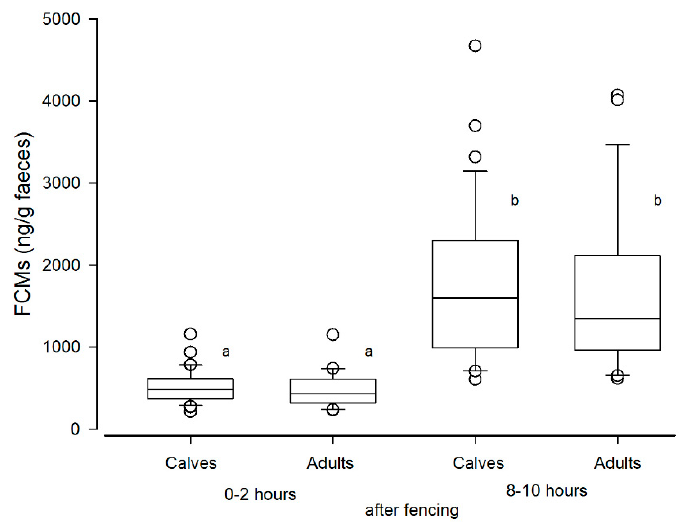
Figure 3. Concentrations of faecal cortisol metabolites (FCMs) in reindeer collected immediately after fencing (0–2 h; morning, n = 51 where 31 were calves and 20 adults) and later after handling and calf marking (8–10 h; evening, n = 63 where 34 were calves and 29 adults). Dissimilar letters indicate significant ( p < 0.001) differences.